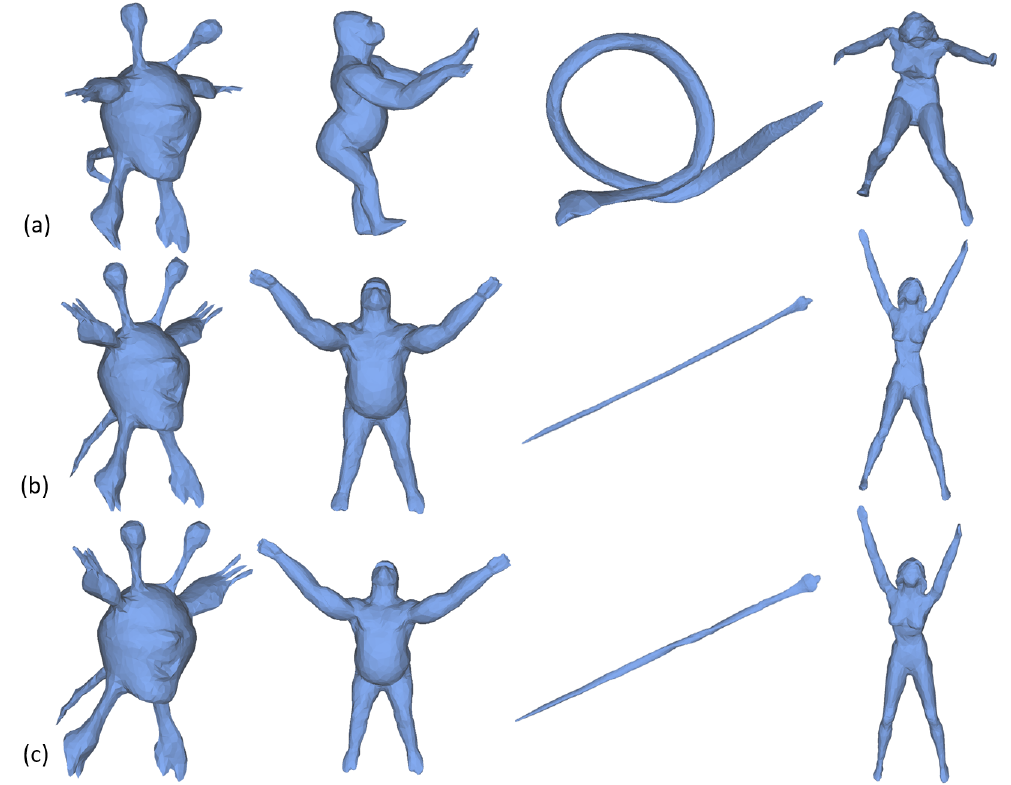
Figure 7. Comparison with state-of-the-art method [24]. ( a ) Original meshes. ( b ) Results of DPMU. ( c ) Our results. The corresponding time consumption is shown in Table